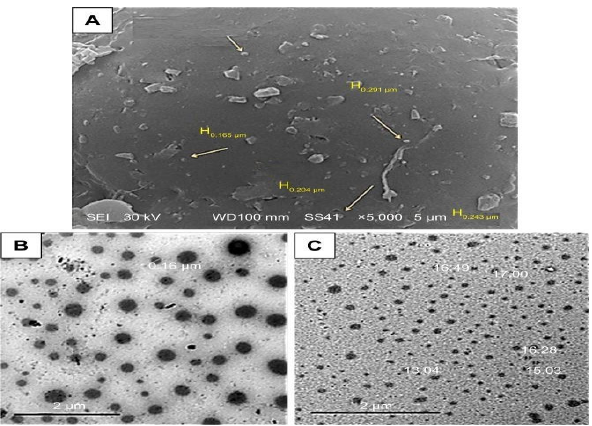
Figure 2. ( A ) SEM photographs of DTX-loaded PLGA NPs design. ( B , C ) TEM photographs of PLGA NP design (Taken from open access journal under the terms of creative common attributes) [26].